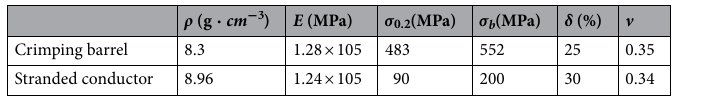
Table 2. Relevant mechanical properties of crimping